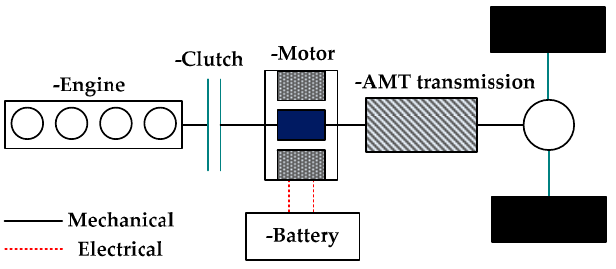
Figure 1. Structure of P2 hybrid heavy-duty truck. Table 1 . Vehicle specifications.